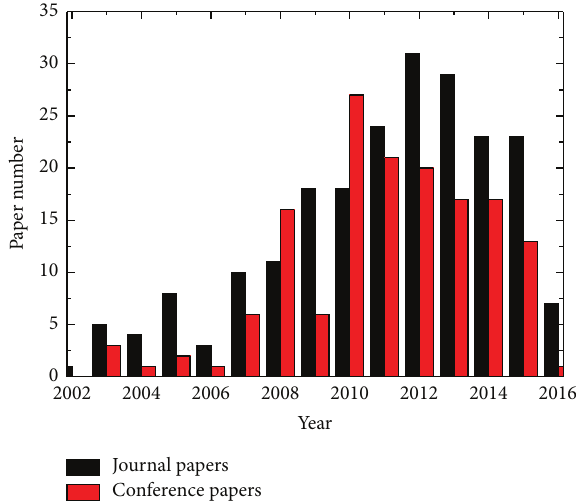
Figure 4: Papers using DE for antenna design from 2002 to May